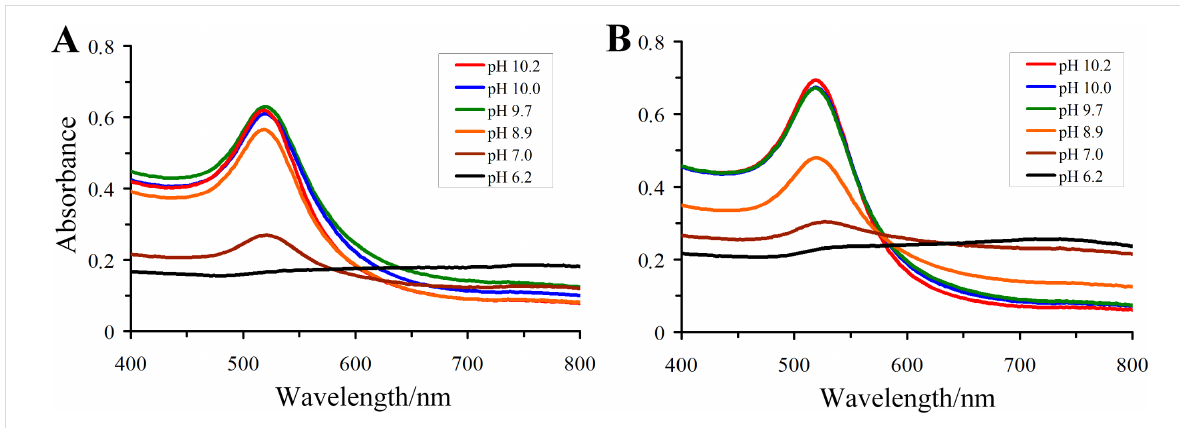
Figure 3: Absorption spectra of solutions of Ara 6 C 2 NH 2 -GNPs ( 3 ) (A) and Ara 6 C 2 EG 7 NH 2 -GNPs ( 4 ) (B), prepared from solutions of containing 100 μ g·mL − 1 of glycosides and 0.9% NaCl, at different рН values. The glycan components in glyco-GNPs 3 and 4 are hexasaccharide fragments (Ara 6 ) of mycobacterial LAM/AG with amino groups at the terminal position of short ( С 2 ) or elongated ( С 2 Е G 7 ) spacer aglycons (Ara 6 glycosides 1 and 2 , respectively; see Figure